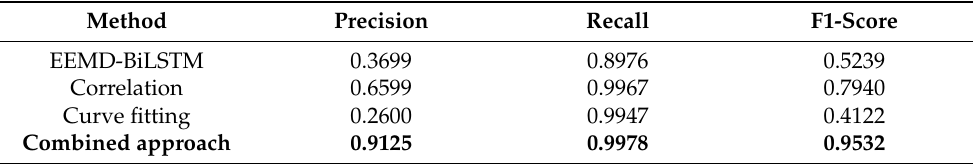
Table 11. Comparison of anomaly data detected by the proposed combined approach with the individual